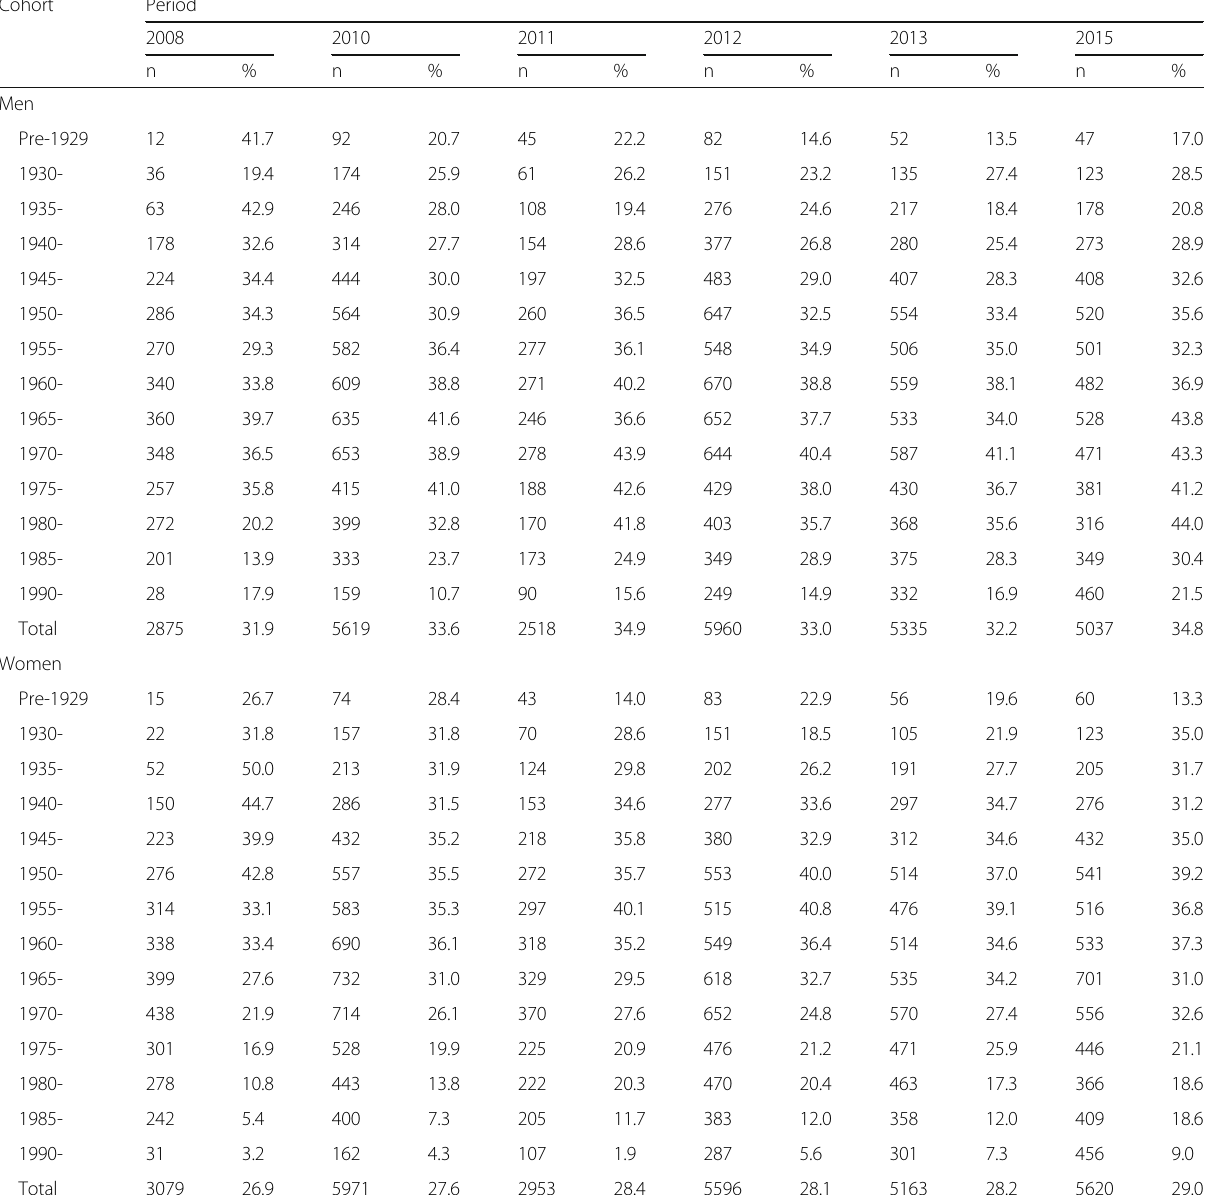
Table 2 Overweight prevalence by period and cohort among adults in China, CGSS2008 – 2015 Cohort